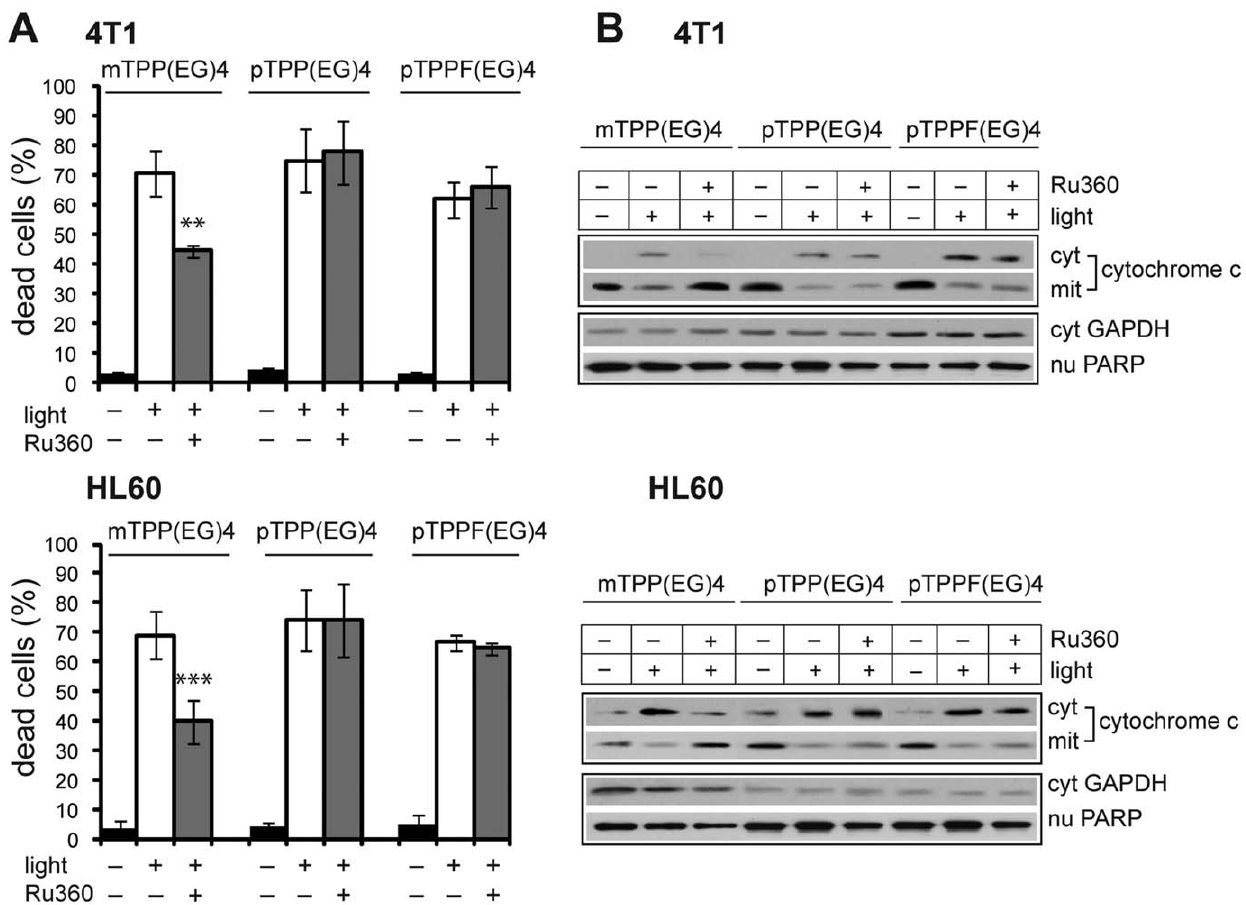
Figure 5. Effect of Ru360. ( A ) Cells loaded with EG-porphyrin derivatives were pre-treated with Ru360 (5 m M 4T1, 4 m M HL60) for 1 h to inhibit Ca 2 + mitochondrial uptake. After irradiation the cells were further incubated in medium and their viability was determined 24 h later by the trypan blue exclusion method. The percentage of dead cells was expressed as the mean 6 SD (n=3–6). **P , 0.01, ***P , 0.001 represents statistical differences between PDT-treated cells vs. PDT-treated cells in the presence of Ru360. ( B ) Cells were preincubated for 1 h with Ru360 (4–5 m M) and 2 h post-irradiation the cytosolic, mitochondrial and nuclear extracts were prepared and analyzed by Western blotting with specific antibody recognizing cytochrome c, GAPDH and PARP. Results are representatives of at least three